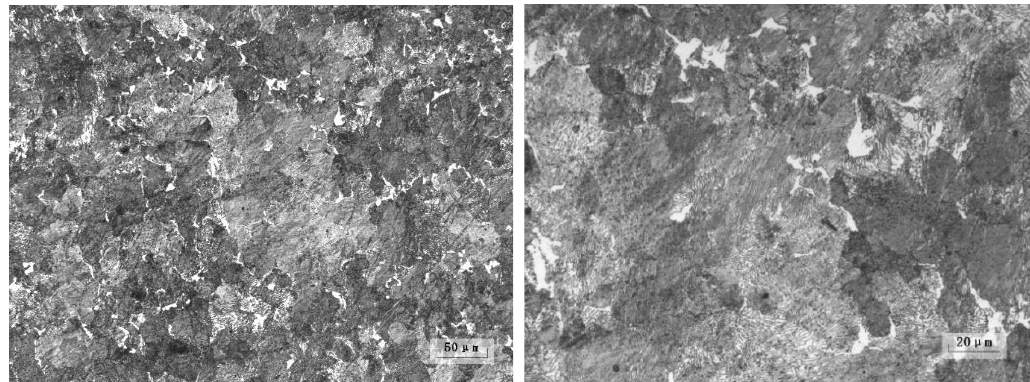
Figure 8. Fracture morphology of sample 2#.